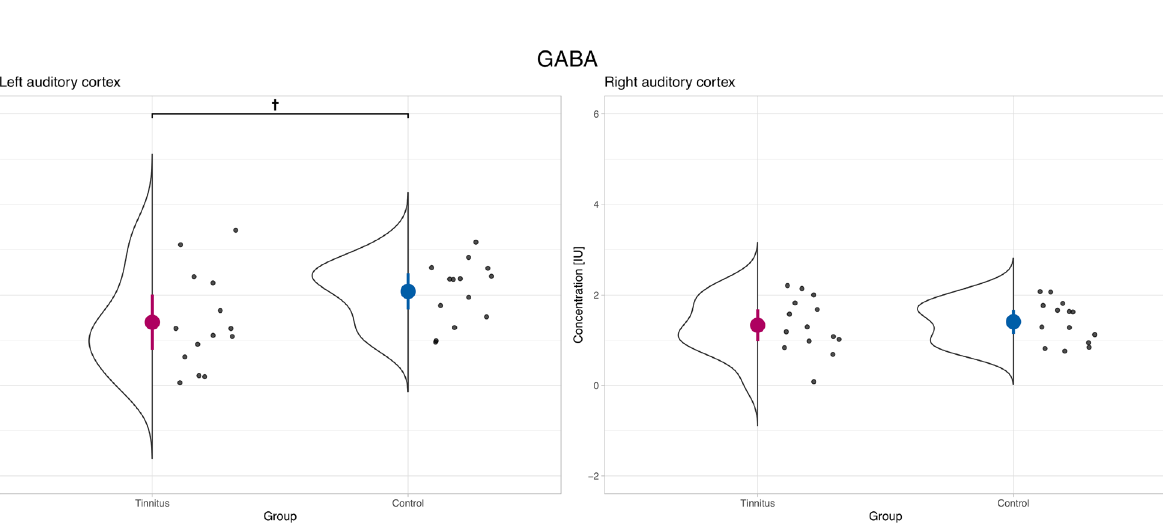
Figure 3. GABA concentration levels in left and right auditory cortex. The colored dot denotes the sample mean. The error bar covers the lower and upper Gaussian confidence limits based on the t -distribution. IU institutional unit.